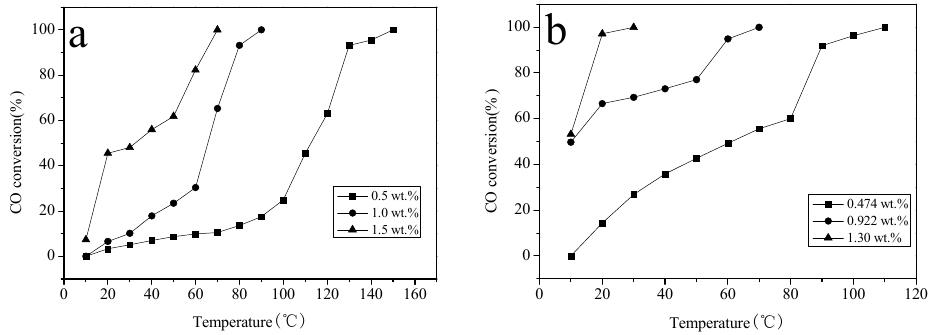
Figure 6. Catalytic activities of Au/Bi 2 WO 6 ( a ) and Au/Bi 2 WO 6 ‐ 400 ( b ) with different Au ‐ contents (calcinated at 300 °C).